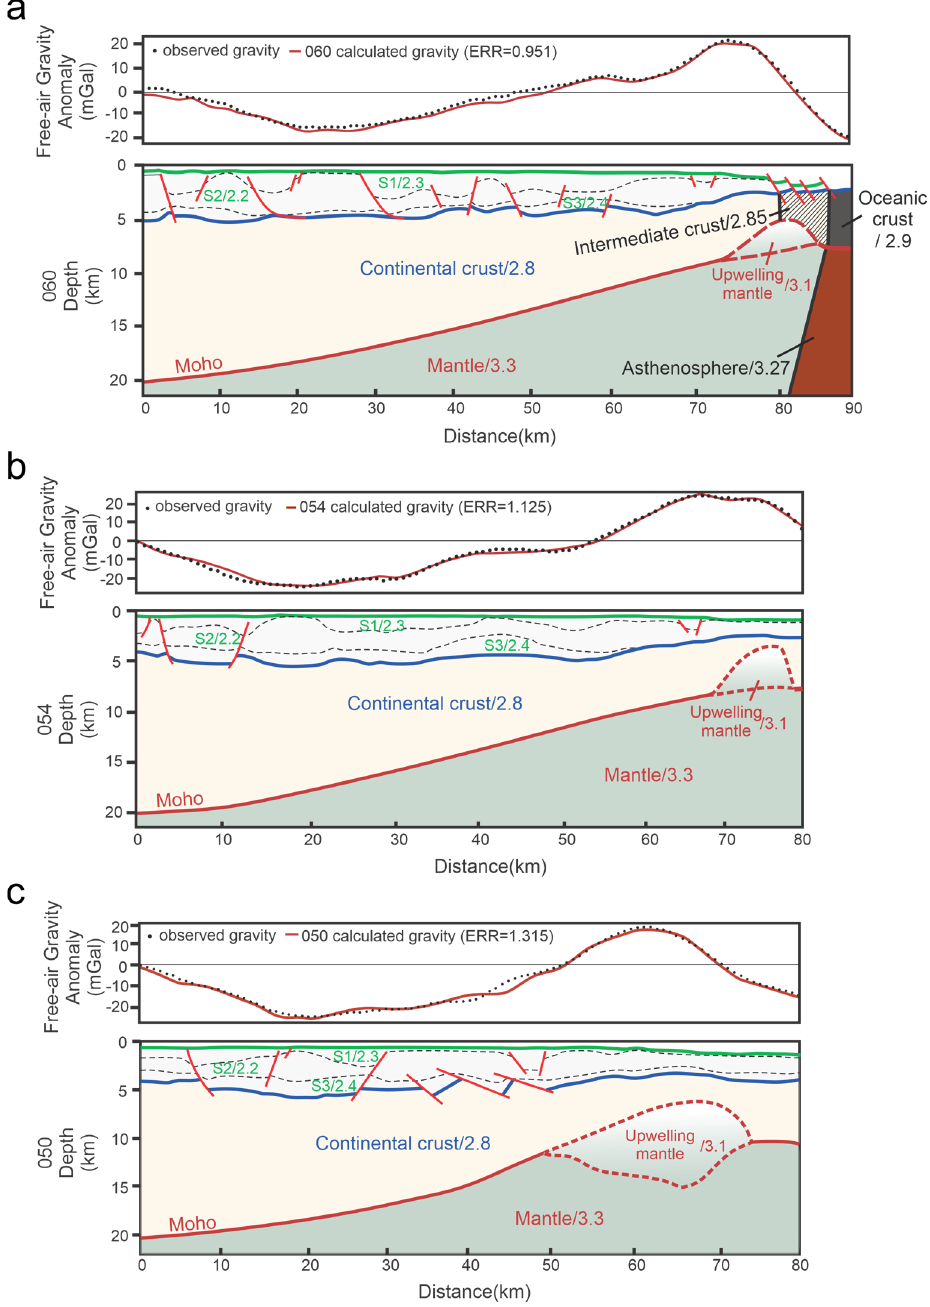
Figure 9. Free-air gravity models of the pro fi le 060 ( a ), 054 ( b ), and 050 ( c ).